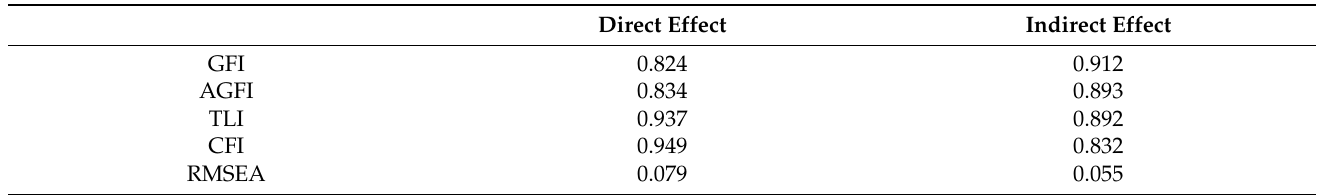
Table 4. Average variance extracted, composite reliability, and collective Cronbach alpha.